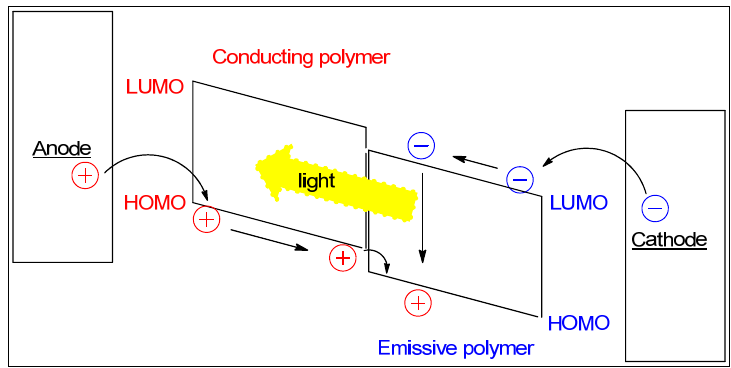
Figure 5. Essential parts of an OLED.